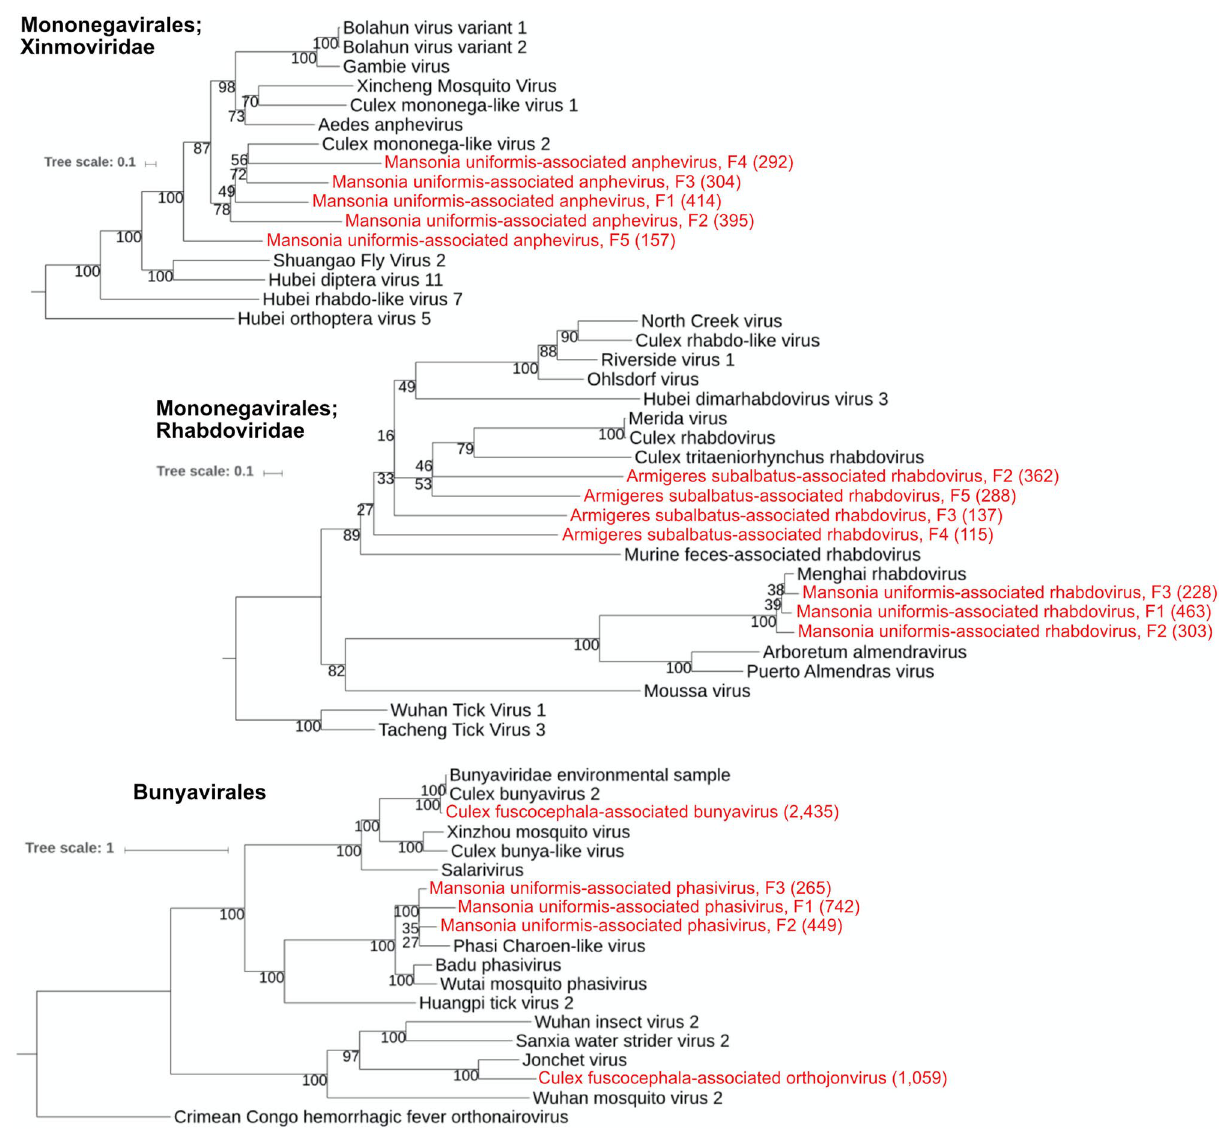
Figure 5. Phylogenetic relationships of the negative sense ssRNA viruses discovered in this study (labeled red) and other known viruses. The analyses were based on RNA-dependent RNA polymerase (RdRp) amino acid sequences. The numbers in parentheses are the lengths of the amino acid